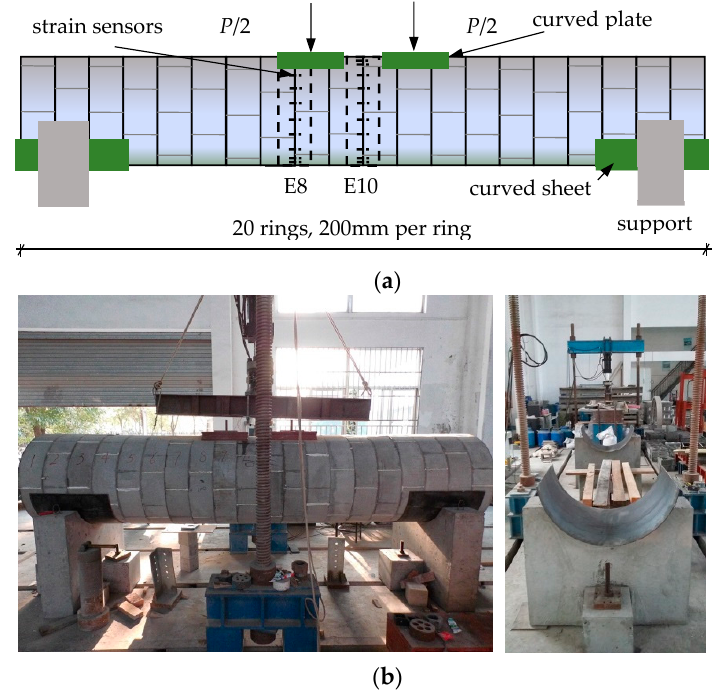
Figure 12. Sensor placement in the scaled-down model. ( a ) S1–S10 (Unit: mm); ( b ) A strain gauge attached to a bolt.